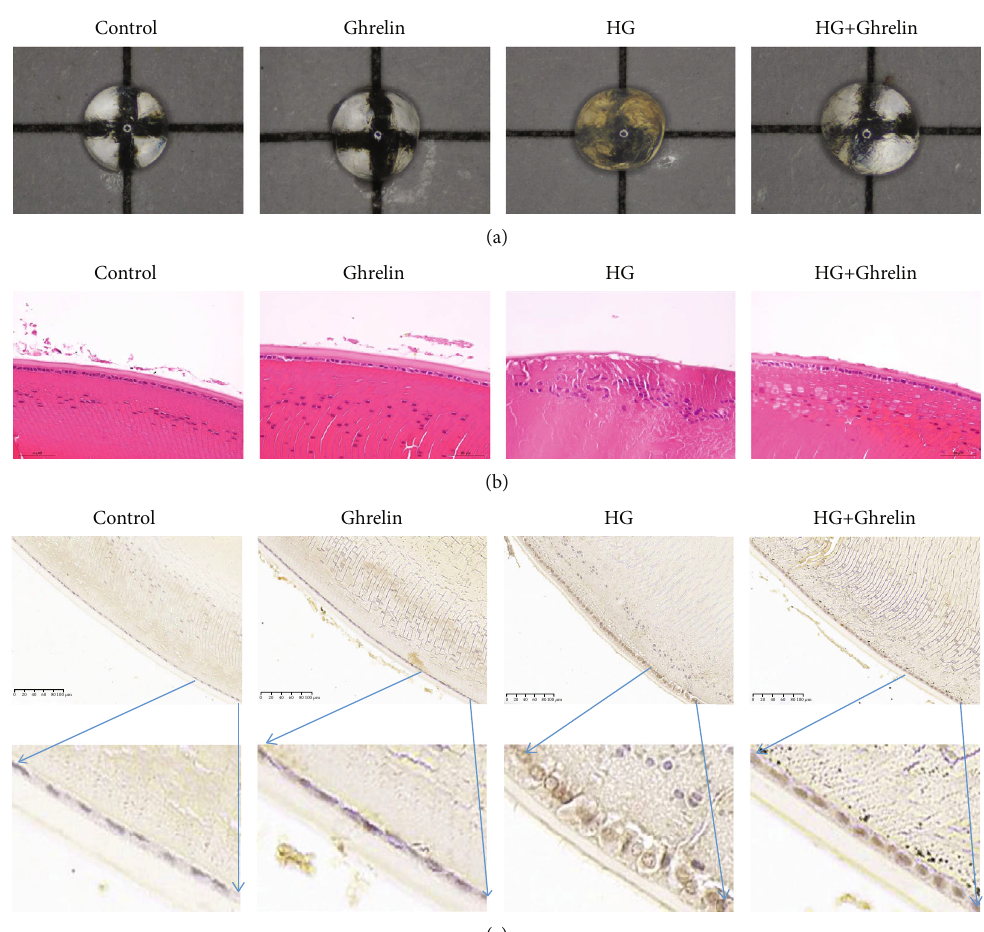
Figure 4: Representative illustrations of anticataract activity of ghrlein. (a) Lenses ’ photos were taken over a grid. (b) Changes in the lenses ’ structure stained with hematoxylin and eosin ( × 400). (c) Changes in the lenses ’ structure stained with TUNEL ( ×